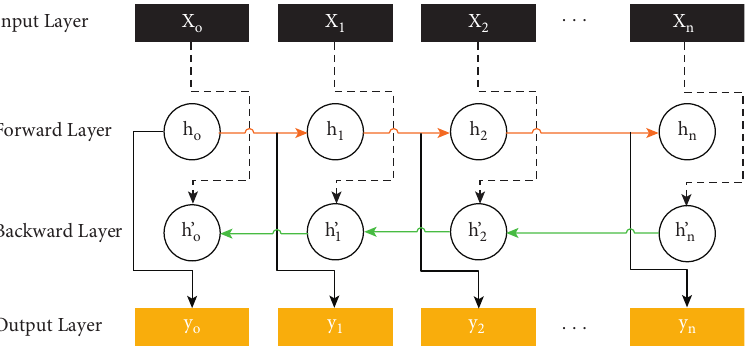
Figure 5: Bidirectional LSTM architecture